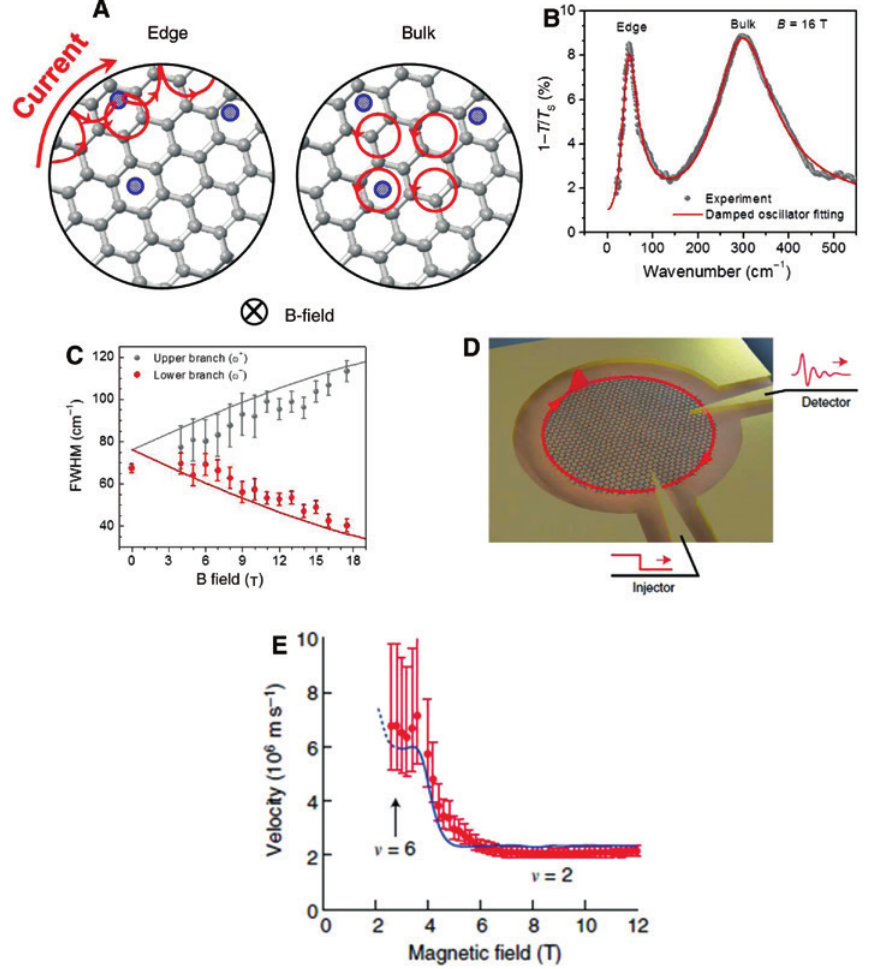
Figure 2: Magnetoplasmons in graphene. (A) Edge and bulk plasmon modes for a graphene microdisk in a magnetic field. (B) Extinction spectrum for a graphene disk array at B = 16 T. (C) FWHMs for the edge mode and bulk mode as a function of the magnetic field. Solid curves are fittings described in [28]. (D) Illustration